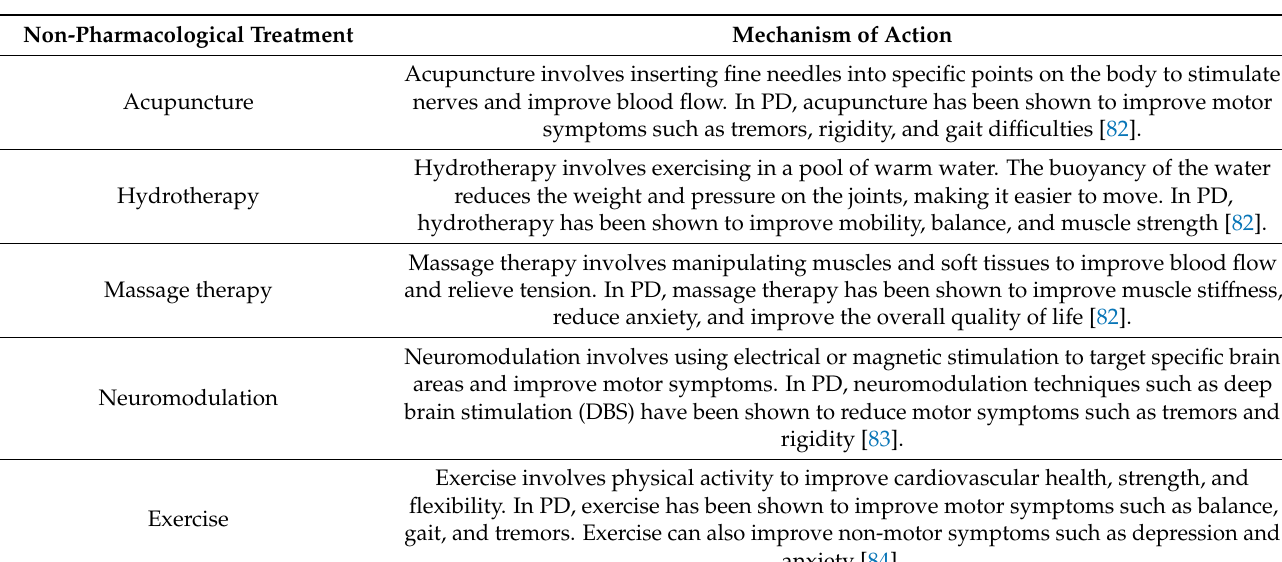
Table 2. Mechanisms of non-pharmacological treatments for